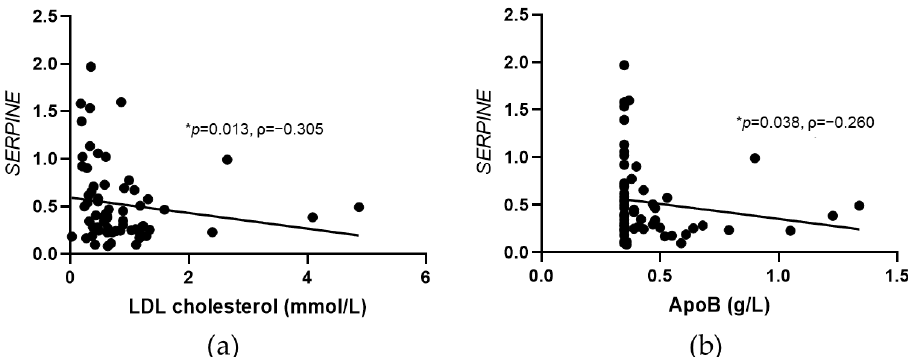
Figure 4. Significant correlations between SERPINE expression and lipid parameters in CAD pa- tients following PCSK9 inhibitors treatment. Significant correlations were found between SERPINE and LDL cholesterol ( a ) and apolipoprotein B (ApoB) ( b ) in patients with CAD after six months of PCSK9 inhibitors treatment. Scatter plots are shown with the results of Spearman correlation anal- ysis (* p < 0.05; ρ , Spearman ’ s correlation coefficient). Gene expression data are normalized to geo- metric mean of glyceraldehyde-3-phosphate dehydrogenase ( GAPDH ) and ribosomal protein L13a ( RPL13A ).